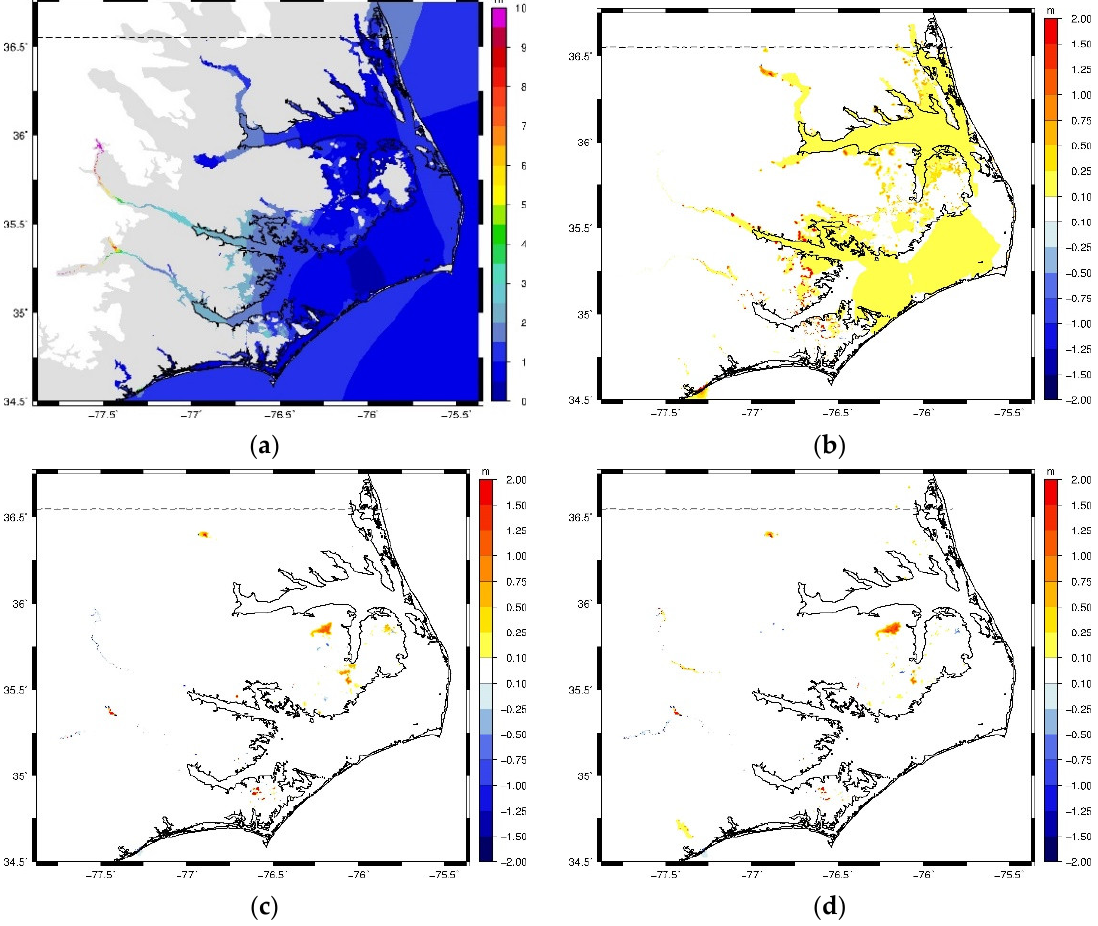
Figure 13. ( a ) Maximum WSE (above MSL) for the full TWP78R15 simulation with all source terms activated. Differences in maximum WSEs exploring influence of ( b ) precipitation addition (TWR15 less TW), ( c ) new lateral source term for riverine inputs (TWP4 less TWF4), and ( d ) additional riv- erine inputs (TWP78 less